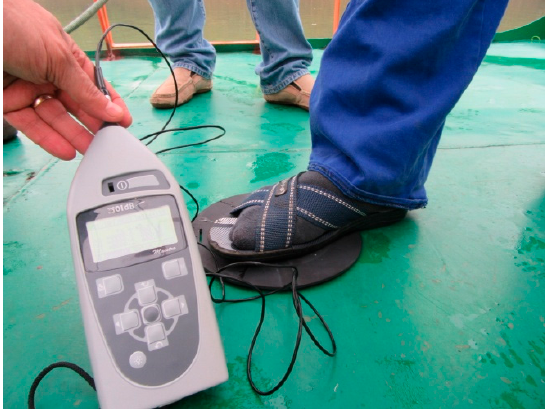
Figure 6. The Vibrometer Maestro 01 dB.